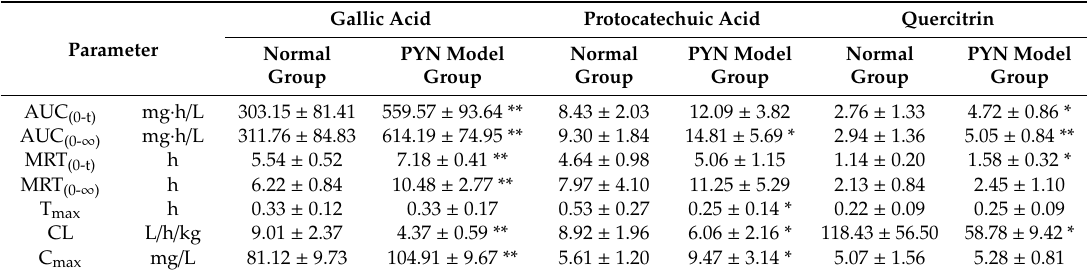
Table 4. Pharmacokinetic parameters of GA, PCA, and QR in rat plasma following the oral administration of Polygonum capitatum extract at a dose of 10 g / kg (mean ± SD, n =